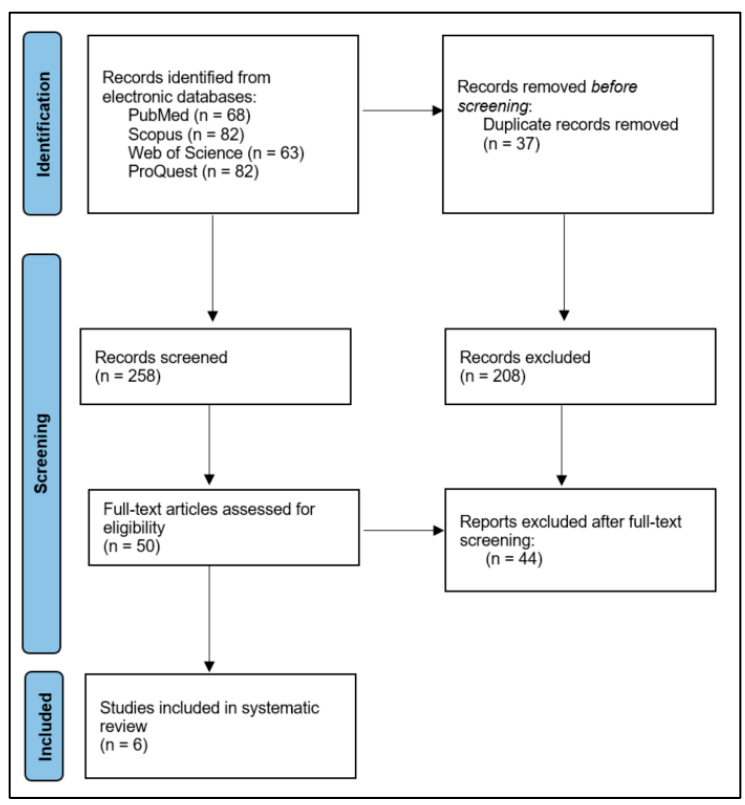
Figure 1 . PRISMA Flow